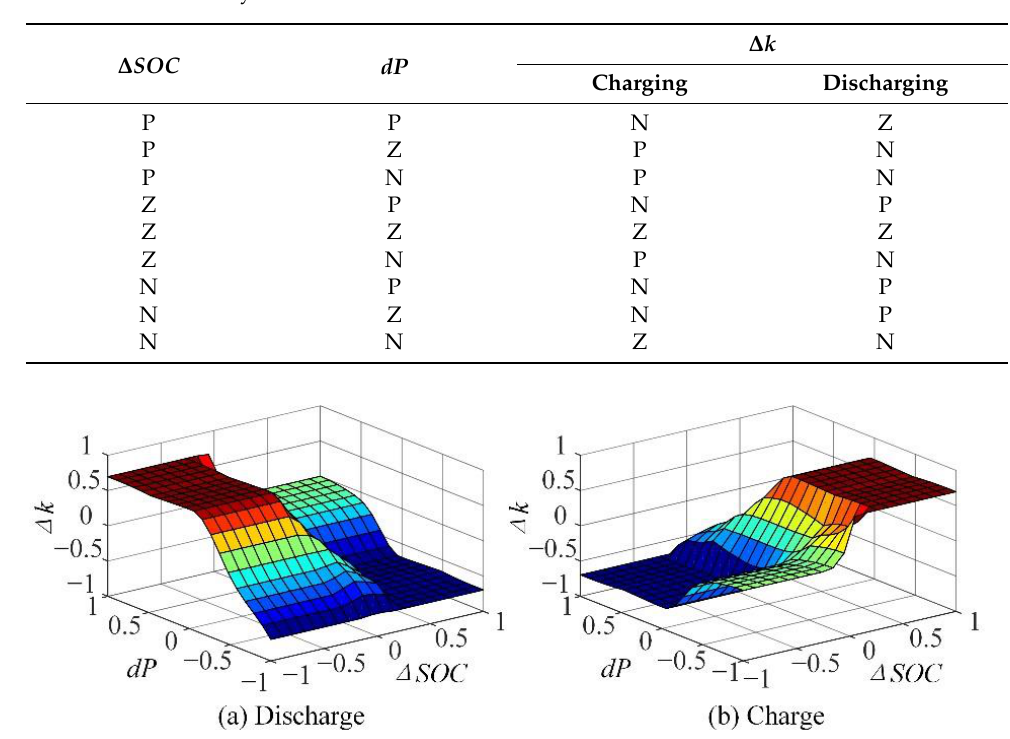
Table 2. Rules of fuzzy controller. Figure 3. Membership function. Figure 3. Membership function.